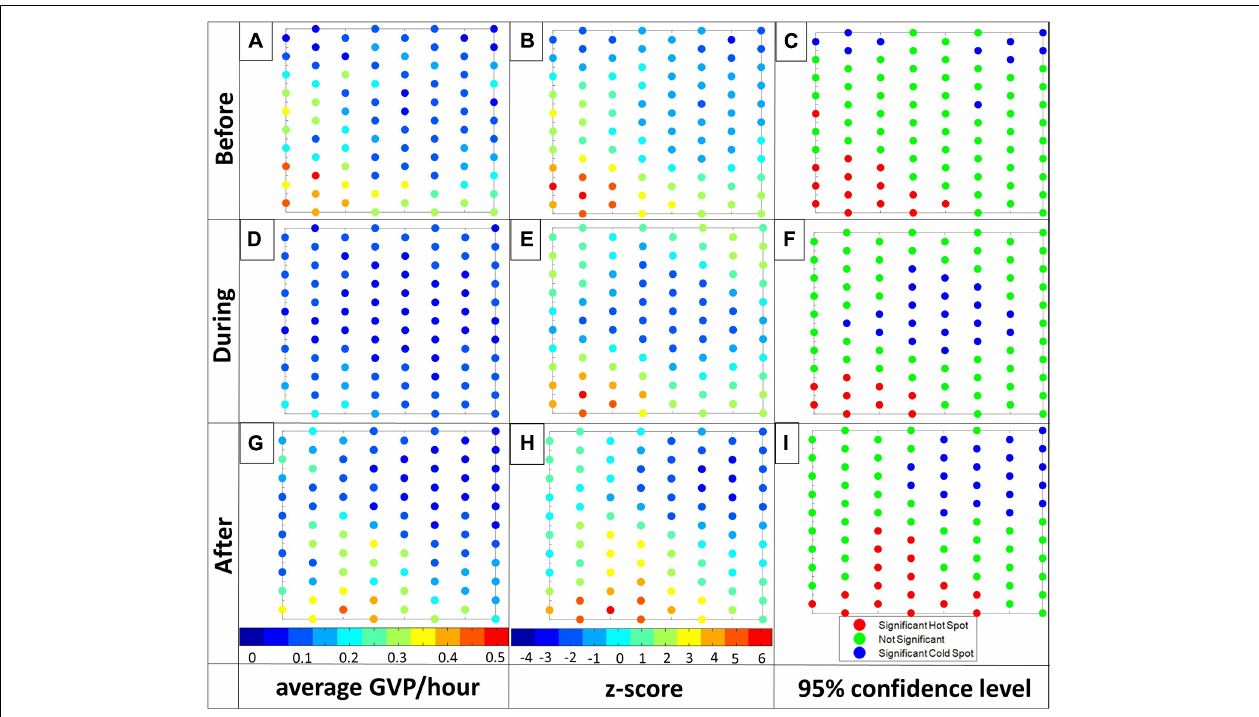
FIGURE 7 | Visualization of the Gi* results for the AUTEC exemplar: Before, During, and After, from top row to bottom row, respectively. From left column to right: 1) the average GVP/ hour with colorbar ranging from 0 (dark blue) to 0.5 (red) GVP/hour, 2) the Gi* z -value with colorbar ranging from –4 (dark blue) to 6 (red), and 3) hot (red) and cold spots (blue) at a 95% confidence level. Note: For ease in displaying, individual hydrophone values were rounded to the closest number on the color bar for columns one and two. Letters associated with each plot are used for ease in referencing individual plots in the